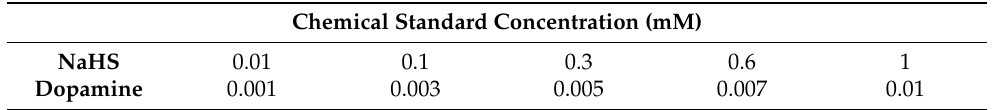
Table 3. Artificial modified-cerebrospinal fluid (CSF) standard concentration (mM) at different concentrations.